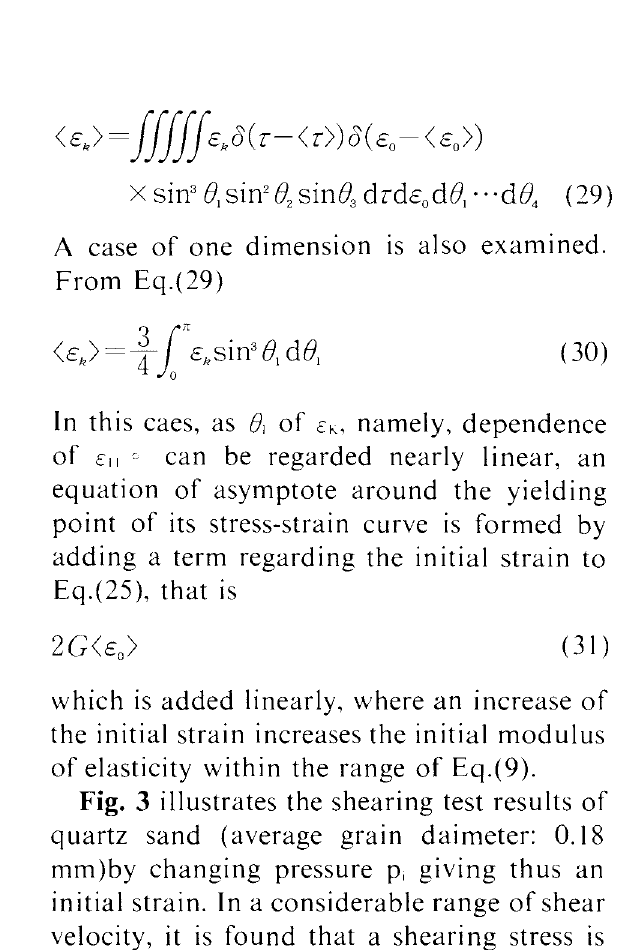
Fig. 2 Stress and strain curves picturing for three different value of the standard deviation b (Y; effective yield